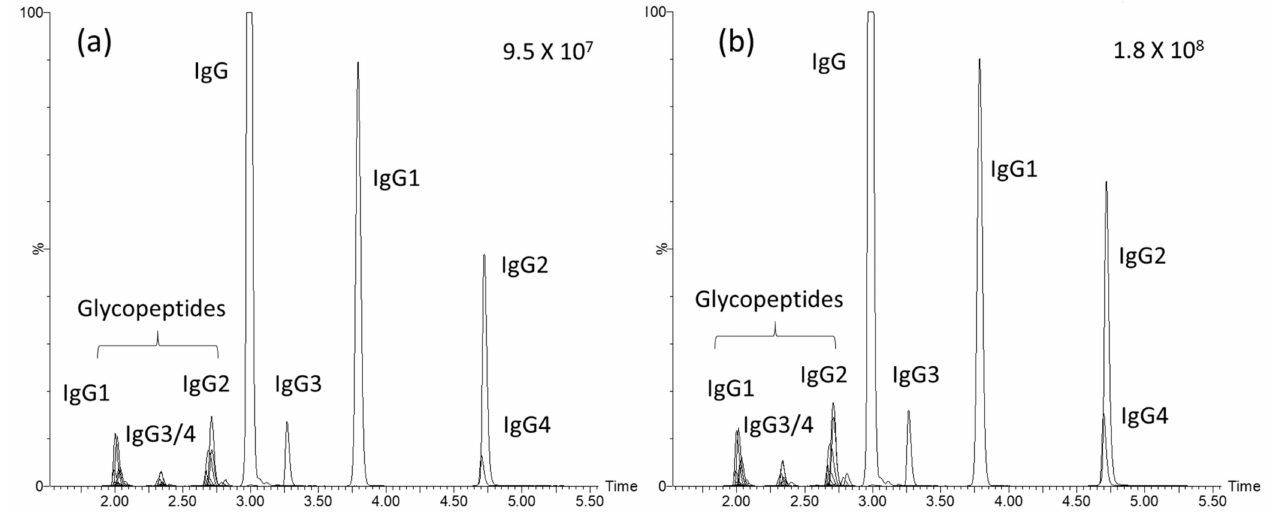
Figure 1. Chromatograms of total immunoglobulin G (IgG), IgG subclasses, and IgG glycopeptides from individuals with low and high eGFR values. ( a ) Participant with an eGFR of 15 mL/min/1.73 m 2 . ( b ) Participant with an eGFR of 171 mL/min/1.73 m 2 .